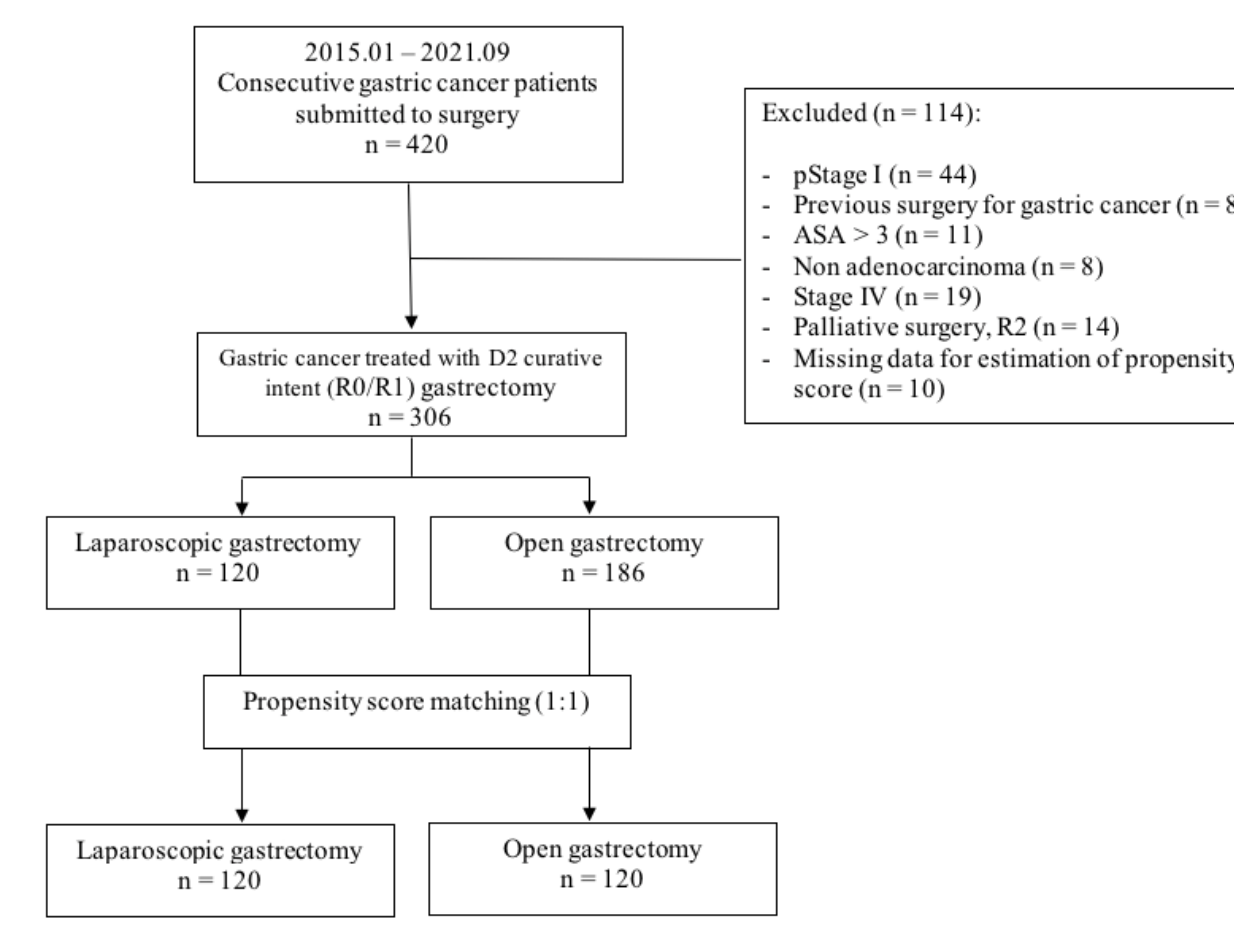
Figure 1. Flowchart of patient enrollment.